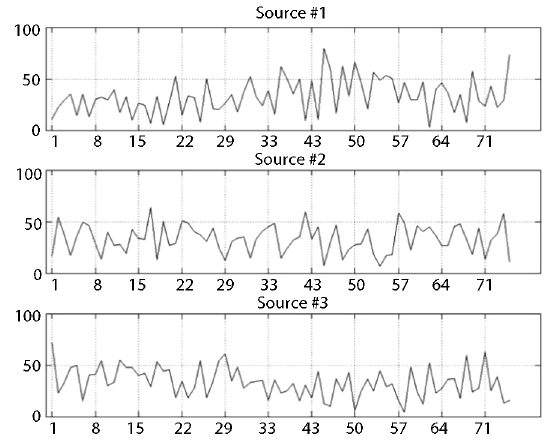
Figure 3. Variations of source contributions (%) for each sample